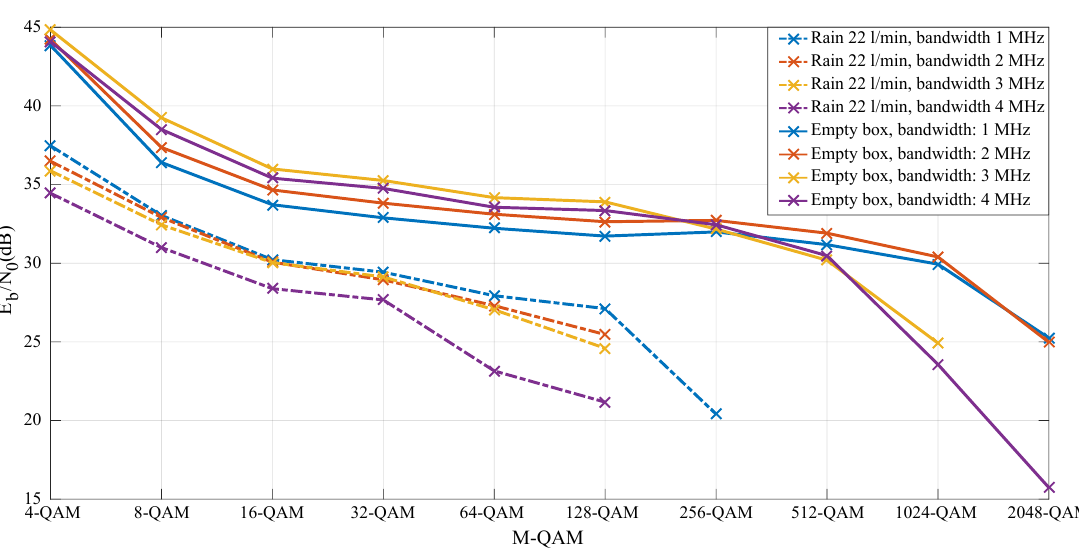
Figure 30. E b /N 0 / distance relationship for Octavia tail-light with different M-QAM and bandwidths —scenario 4—Rain 22 L/min.